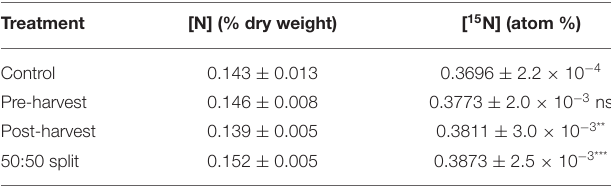
TABLE 2 | The [N] and [ 15 N] of soil samples taken from 0 to 10cm depth on July 11, 2018, during winter dormancy. Mean values ± SE, n =